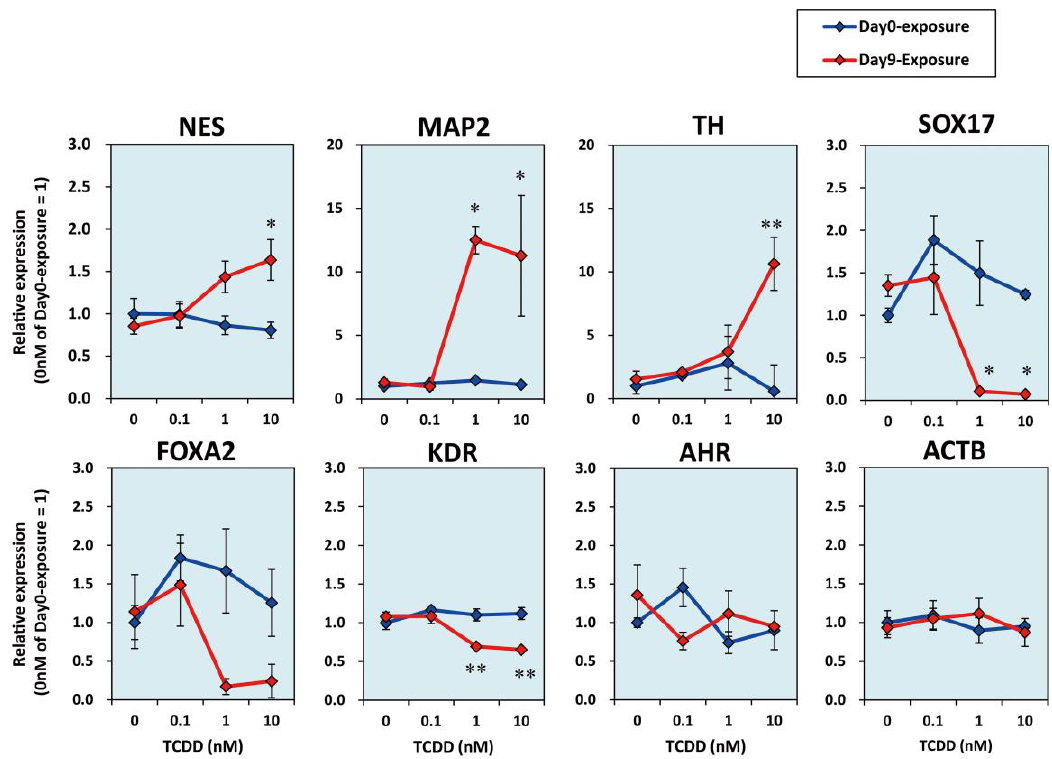
Figure 3. Effects of TCDD exposure on the mRNA expression levels of neural and germ layer markers. On a 24-well plate, all cells were lysed on Day28 of culture (Figure 1C). Blue line, Day0-exposure groups; Red line, Day9-exposure group. The NES, MAP2, TH, SOX17, FOXA2, KDR, AHR , and ACTB mRNAs were subjected to RT-qPCR analyses. Data are expressed as mean ± SE ( N = 3). One-way ANOVA was carried out followed by Dunnett’s test as post hoc (*, p < 0.05; **, p < 0.01).